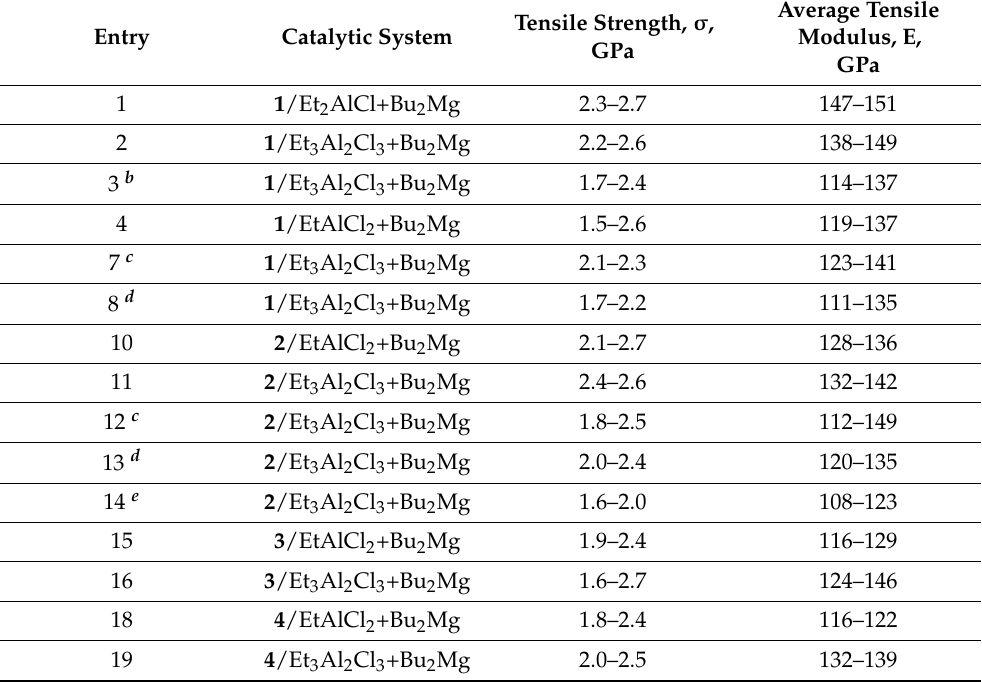
Table 2. Mechanical properties of UHMWPE-oriented film tapes a